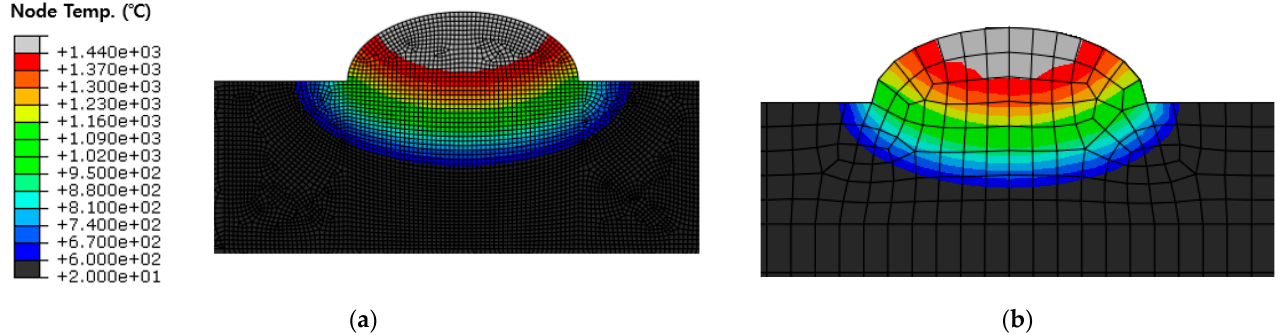
Figure 13. Comparison of temperature distribution 0.1 s before the heat source arrives. ( a ) Simplified model with fine meshes. ( b ) Original dimension model with coarse meshes.